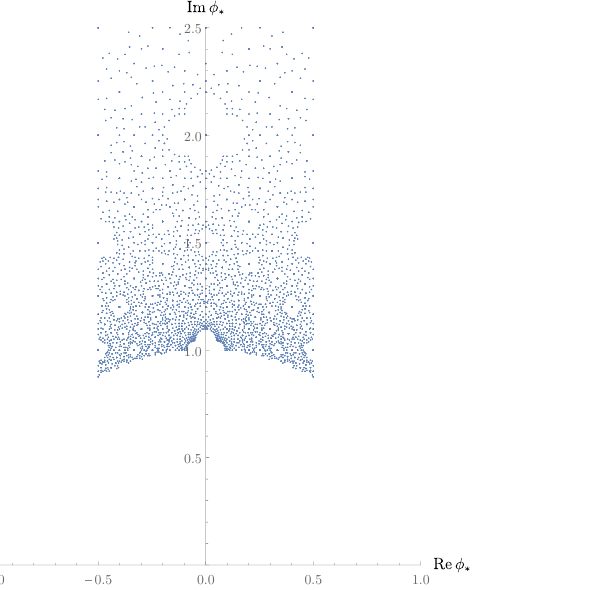
Figure 1 . A sampling of vacua (7.25) (cid:12)lling the fundamental domain (7.22), for the values of the constants e I ; m J 2 [ (cid:0) 11 ;